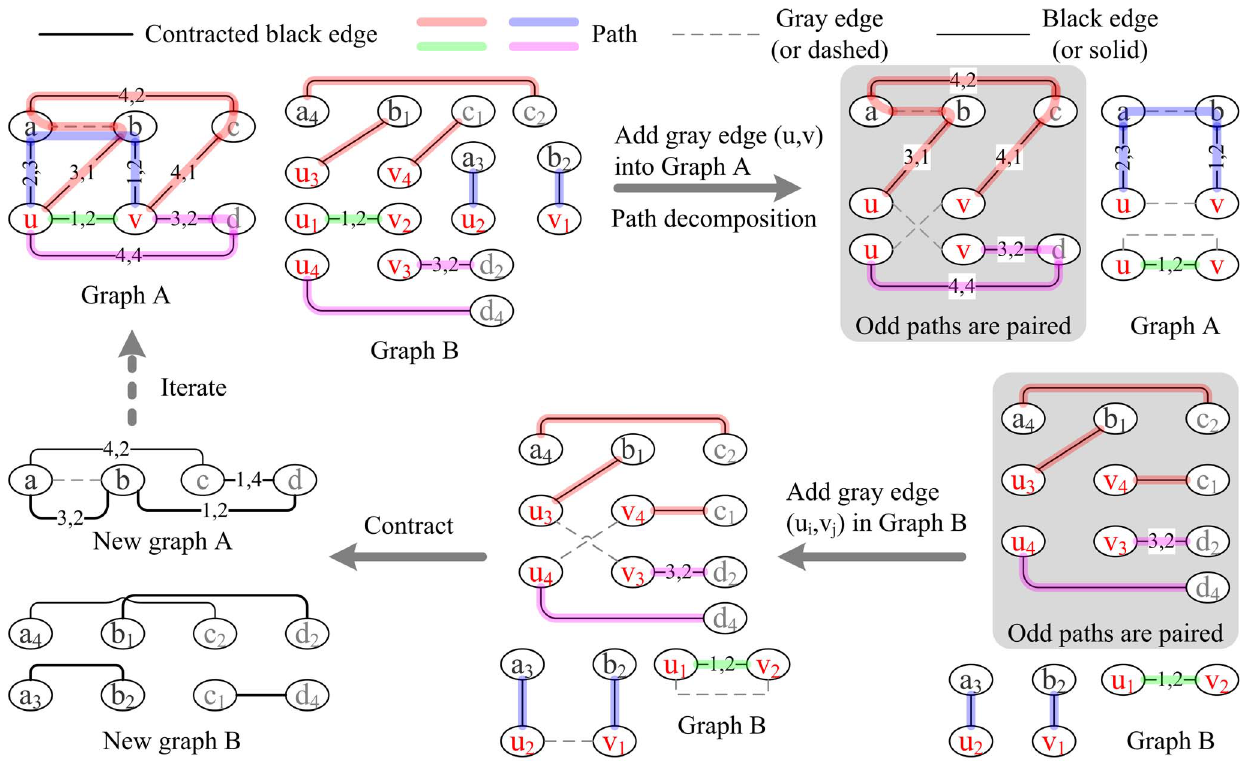
Figure 3. Adjacency inference in H (i.e., gray dashed edges in graph B) from matched vertices u, v in graph A. Vertices a, b are matched vertices that have not been contracted. Vertices c, d are unmatched. Black solid edges are derived from PG(G obs ), CPG(G obs ) or contracted edges. The four different paths found by find_path(u, v) are as follows: (1) (u, v) (green), (2) (u, a, b, v) (blue), (3) (u, b, a, c, v) (orange), and (4) (u, d, v) (pink). In graph A, the first two paths are odd and form two even cycles – (u, v, u) and (u, a, b, v, u) – by adding the gray edge (u, v) in the top right panel. The former disappears after contraction, while the latter generates a new black edge (a, b) in the bottom left panel. The last two paths are merged by two same gray edges (u, v) to form an even cycle – (u, b, a, c, v, u, d, v, u) – that is contracted and generates two new black edges, (b, d) and (c, d). Two numbers on each edge of graph A indicate the copy IDs of the two corresponding vertices in graph B.